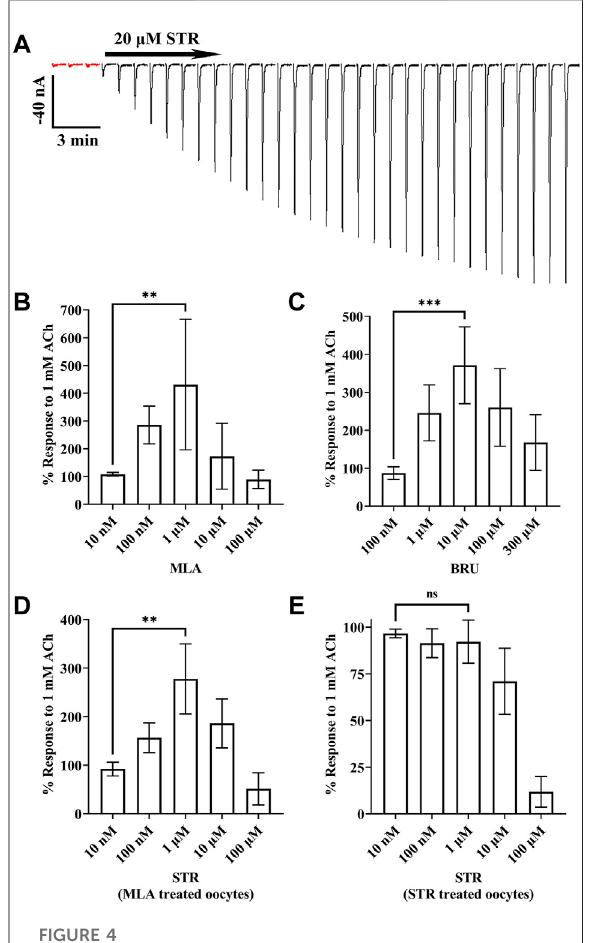
STR but enhanced by choline The differential results obtained with STR on α 9, α 10, and α 9 plus α 10 expressing oocytes prompted us to examine